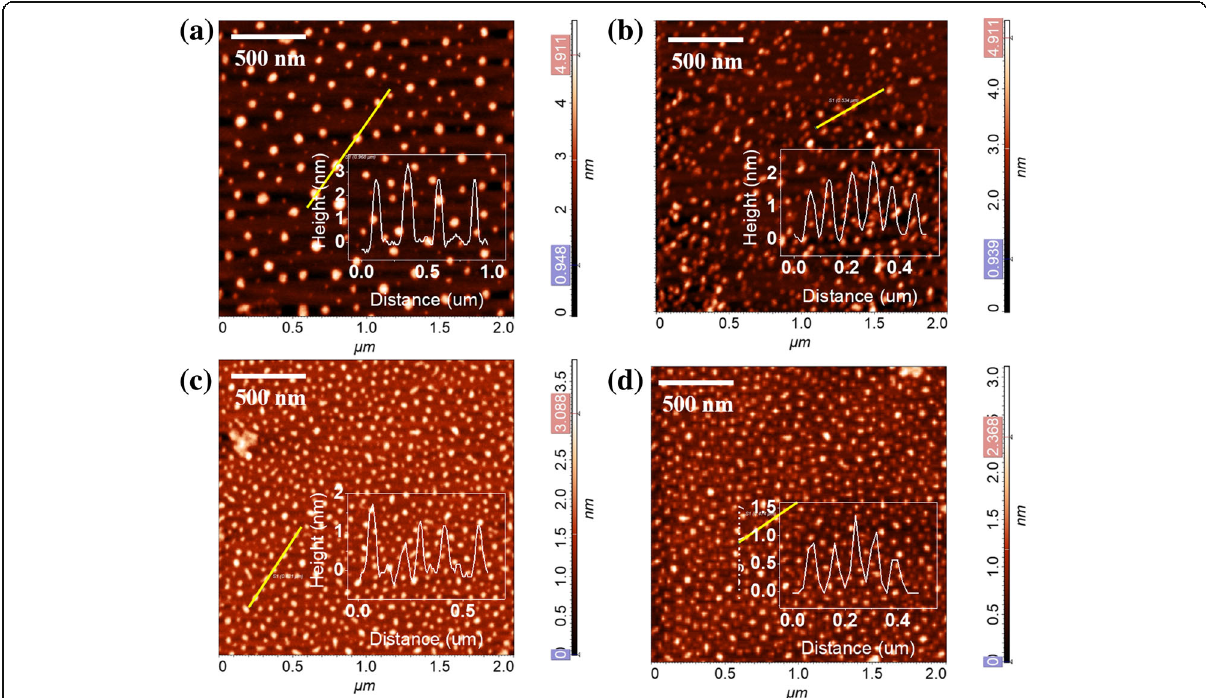
Fig. 1 AFM images of few layer nano-graphene with various UV exposure time a – d : 0, 30 s, 50 s, 240 s, insert is the height distribution of